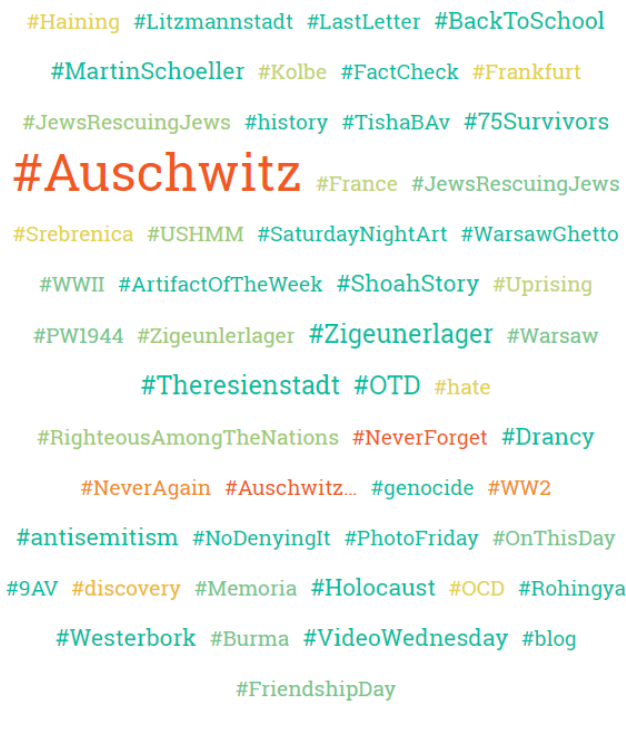
Figure 1. Hashtags that the museums used most frequently on Twitter (relative frequency is expressed both by text size and by colour). For Facebook, the most popular words employed in posts were “camp” (N = 163), “Nazi” (N = 130), “Jews” (N = 114), and “Holocaust” (N = 109). In terms of differences among the three profiles, AMM’s most frequent words were “camp” (N = 102), “prisoner” (N = 68), and “Auschwitz” (N = 50), while USHMM’s were “Nazi” (N = 101), “Holocaust” (N = 63), and “Jews” (N = 61) and YV’s were “Holocaust” (N = 37), “family” (N = 26), and “Jews” (N = 26).